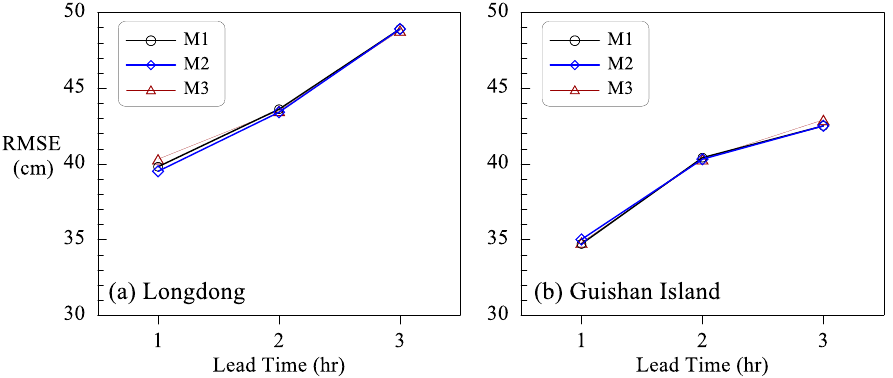
Figure 3. Model performance in root mean squared error (RMSE) during the calibration phase for ( a ) Longdong and ( b ) Guishan Island.